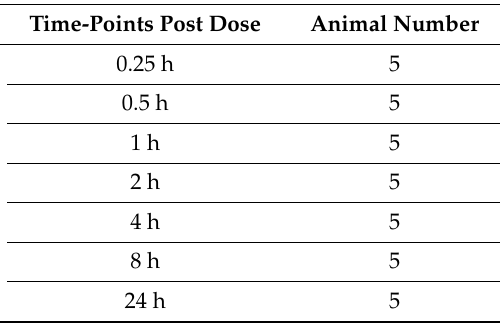
Table 1. Design of the pharmacokinetic